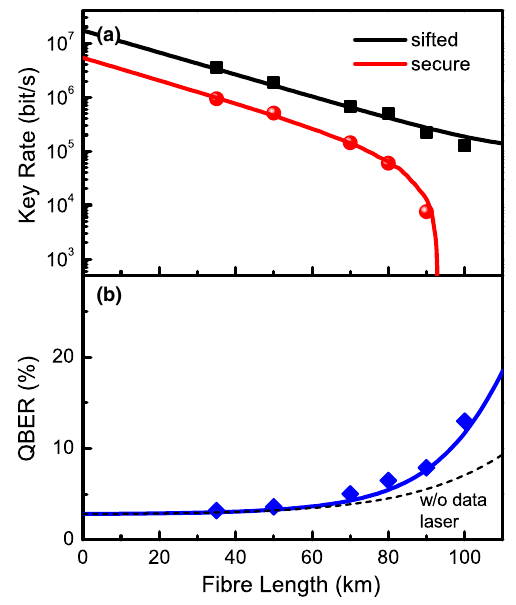
FIG. 4. QKD performance with error-free bidirectional Gb = s data channels. (a) Calculation (line) and measurement (symbols) of sifted and secure key rates as a function of fiber length. (b) Calculation (line) and measurement (symbols) of QBER. Also shown is the calculation of the QBER without contribution from data lasers (dashed